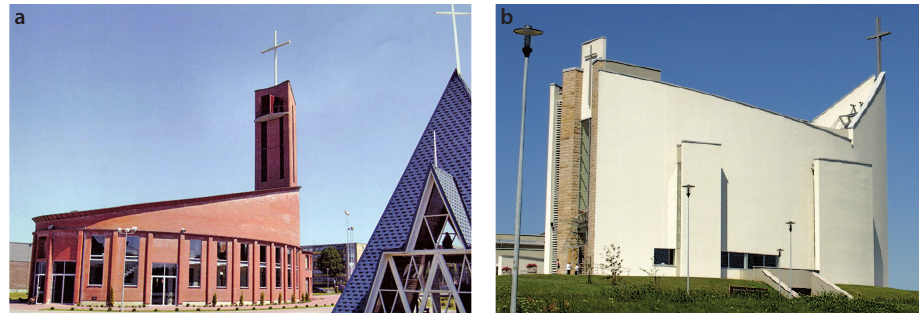
Fig. 8. Churches of Integral model: a – Church of The Divine Presence in Utena (archit.: R. Krištapavičius, M. Jamantas,